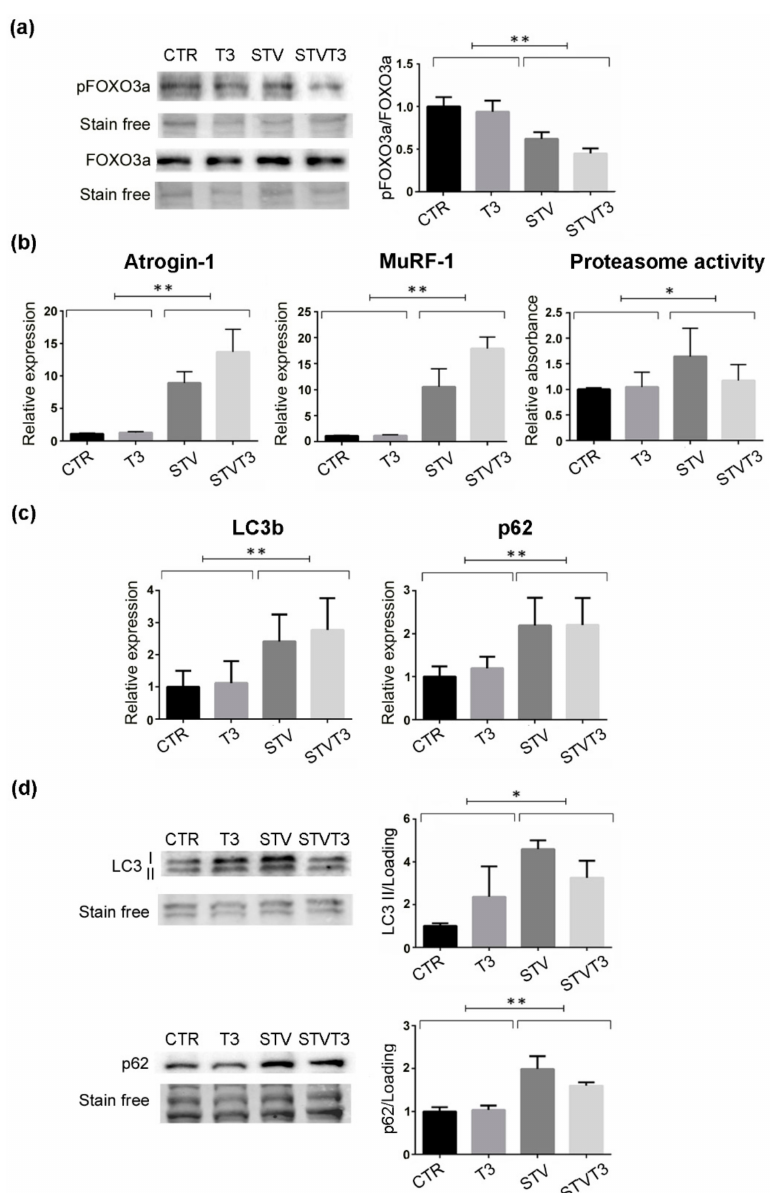
Figure 3. T3 does not prevent catabolic pathway activation in skeletal muscle upon starvation. ( a ) Western blot and densitometric analysis of pFOXO3a / FOXO3a protein levels in TA, 24 h after treatments. Stain-free protein bands were used as a loading control. n = 4 mice per each condition. Data are presented as means ± SEM; STV has a significant e ff ect (** p = 0.0001) by two-way ANOVA. ( b )